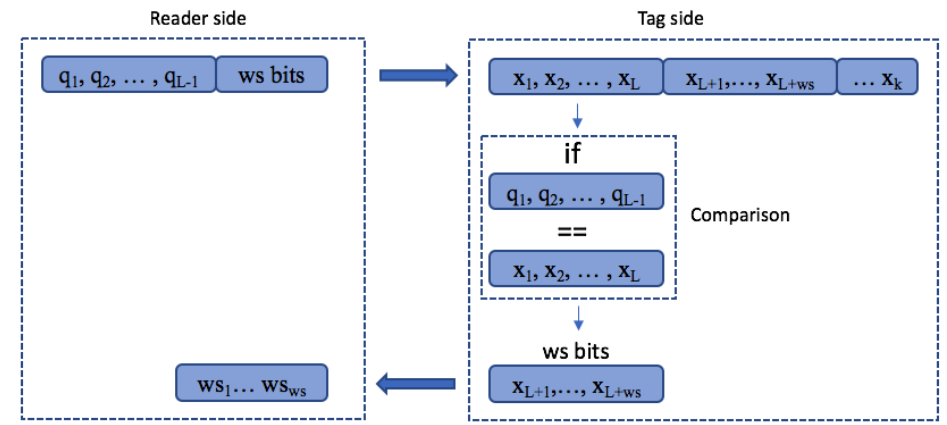
Figure 14. Example of a communication slot between the reader and one